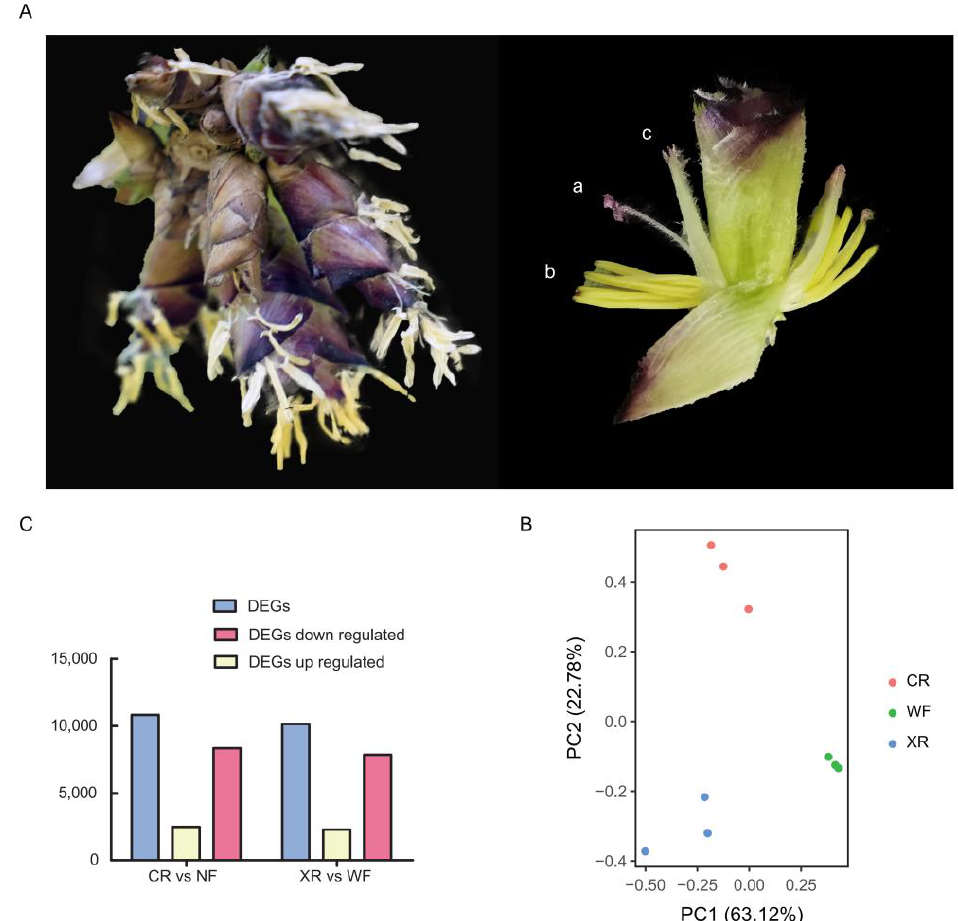
Figure 3. Materials used for transcriptome sequencing and data quality assessment. ( A ) D. latiflorus flower organ; ( a ) pistil; ( b ) stamen; ( c ) palea. ( B ) Multi-dimensional scaling (MDS) plots to analyze the variation among flower organ tissues. ( C ) Multi-dimensional scaling (MDS) plots to analyze the variation among flower organ tissues.